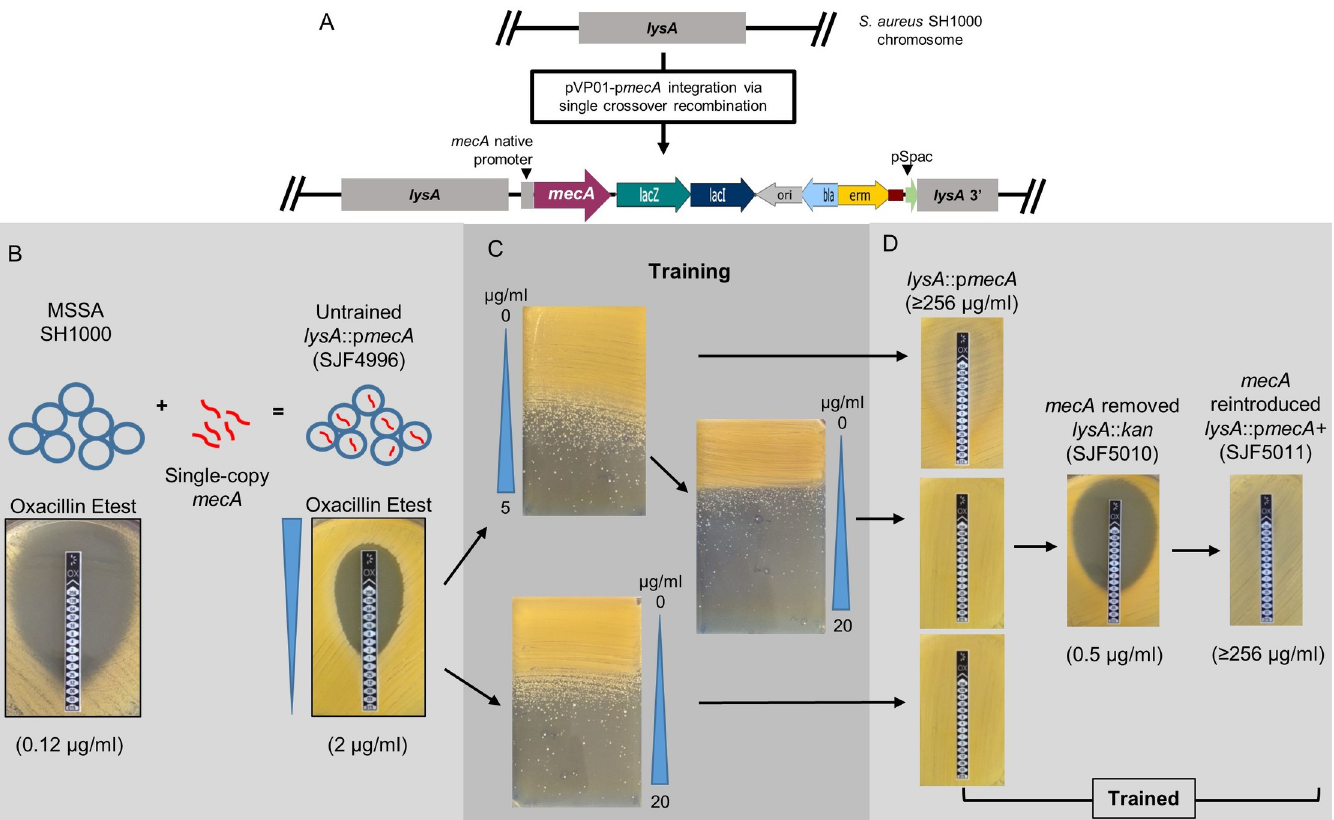
Fig 1. Construction of a chromosomal p mecA fusion in S . aureus SH1000. A) Schematic overview of genomic region of lysA in SH1000 and post integration of pVP01-p mecA resulting into lysA ::p mecA (SJF4996). B) The lysA ::p mecA (SJF4996) construct was produced by transduction from RN4220 lysA ::p mecA (SJF4994). This led to single copy mecA at the lysA locus expressed mecA under its native promoter. C) Subsequently, spontaneous oxacillin resistant mutants were selected using a gradient plate containing either 0–5 or 0–20 μ g/ml of methicillin. Strains with low-level resistance were further selected using an antibiotic gradient plate containing 0–20 μ g/ml methicillin to select high-level resistance. D) Etest strips revealed high-level oxacillin resistance was lost by removal of p mecA and restored via subsequent reintroduction of p mecA at the lysA locus. Oxacillin MICs shown in brackets were measured using the Etest